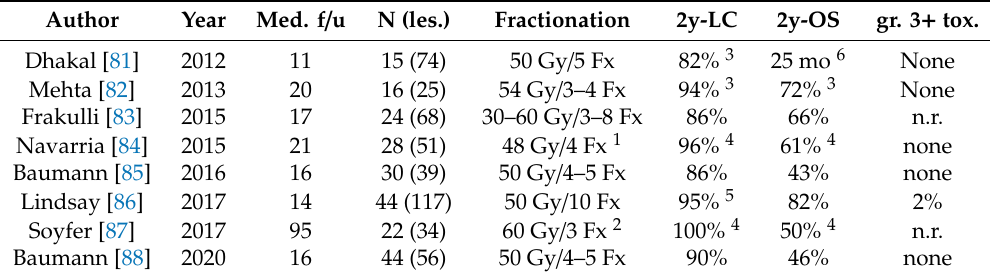
Table 1. Major series of patients with pulmonary metastases of sarcoma treated by